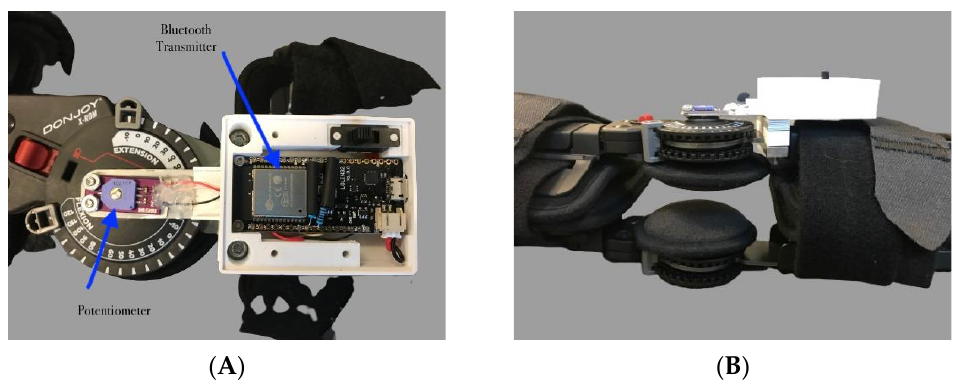
Figure 1. ( A ) Instrumented knee brace with potentiometer and Bluetooth transmitter. ( B ) Profile view of instrumentation in housing.